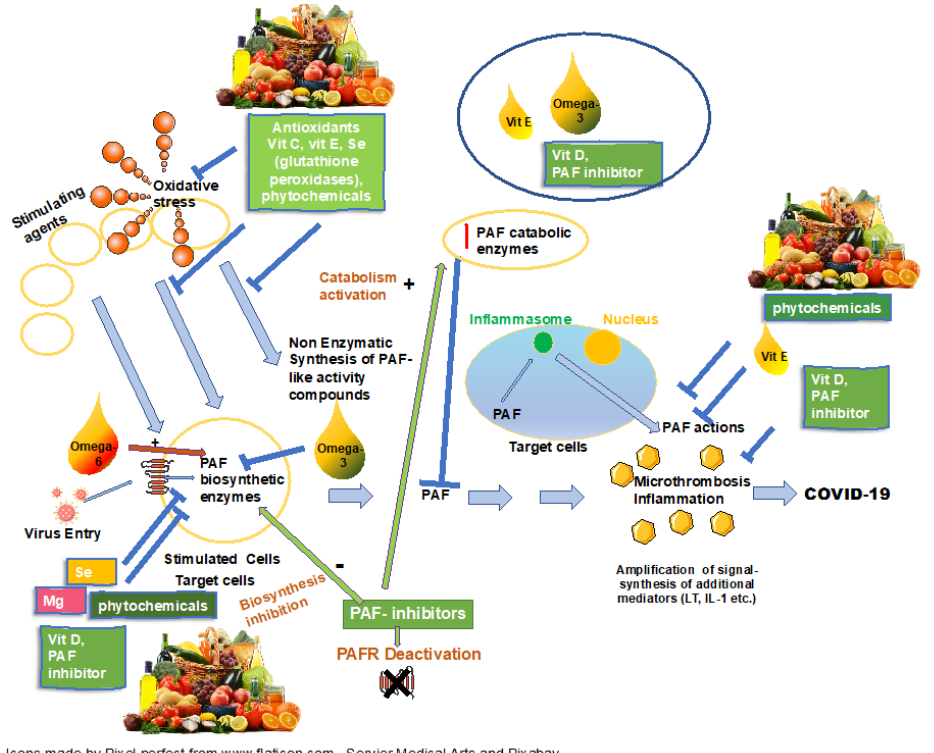
Figure 1. Protective role of nutrition against COVID-19 through modulation of PAF actions and metabolism. Figure legend: Various agents activate cells (usually mast cells) and secrete platelet activating factor (PAF). The produced PAF then affects various target cells (tissue-organs). In acti- vated target cells, coronavirus 19 binds to PAF receptors (PAFRs) exposed to their pericellular